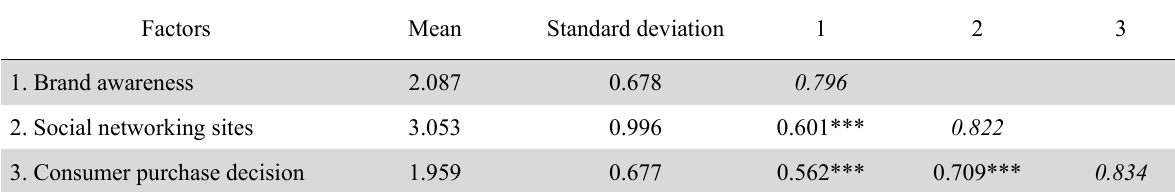
Correlation matrix with mean and standard deviation Factors